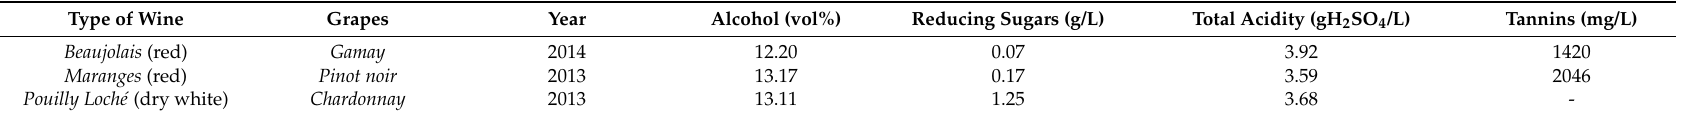
Table 2. Evaluated wine